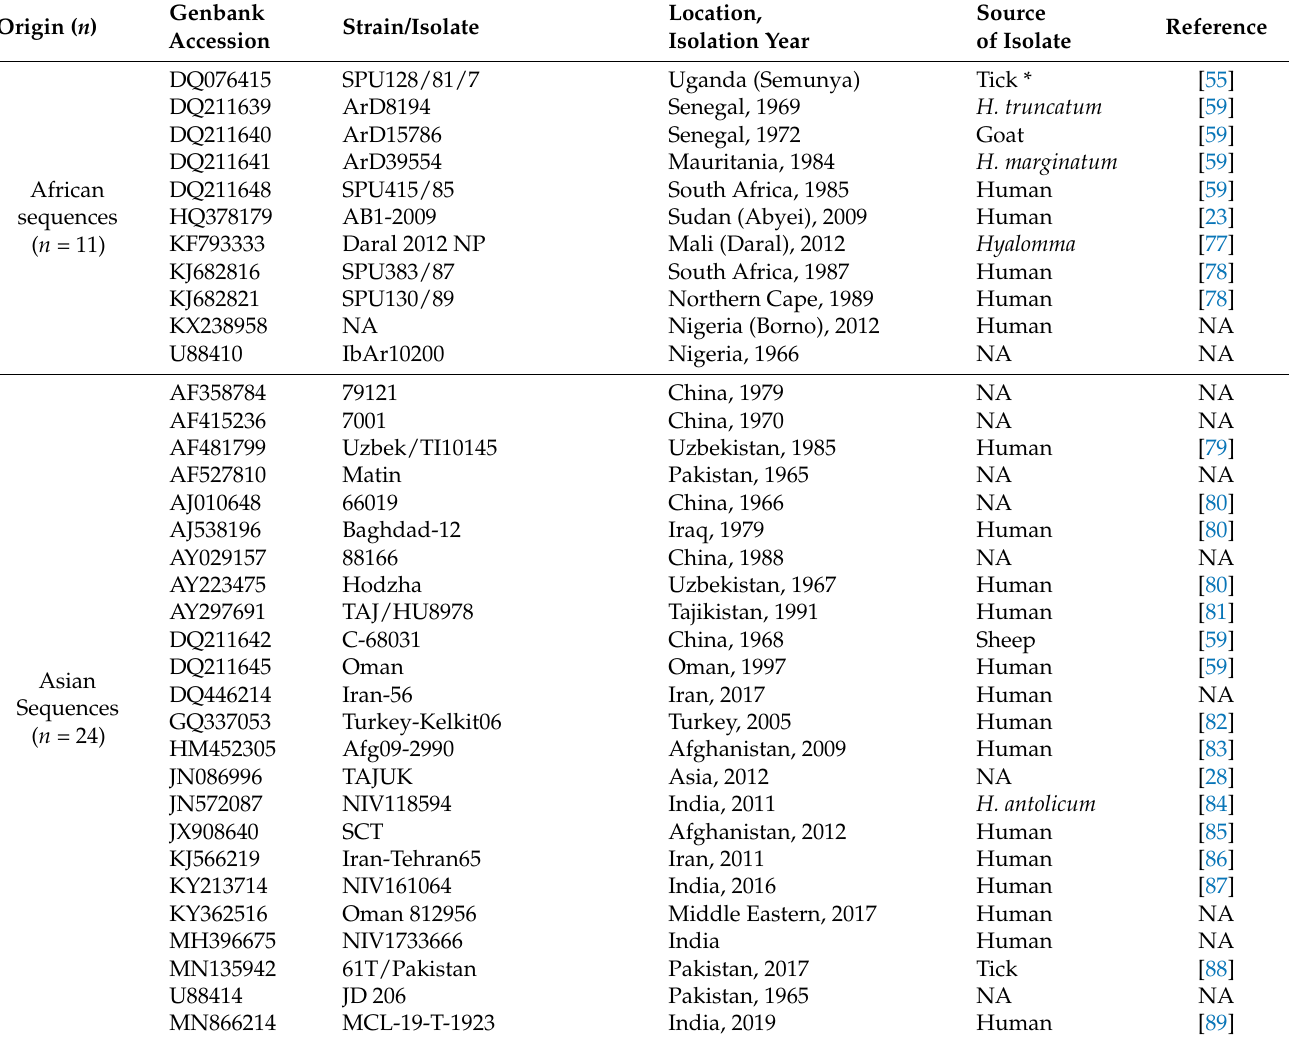
Table 2. Crimean–Congo haemorrhagic fever virus S-segment sequences retrieved from GenBank used in this study grouped by geographical origin of the strains/isolates to obtain a global con- sensus sequence for designing a set of primers for reverse-transcription loop-mediated isothermal assay for the detection of Crimean–Congo haemorrhagic virus RNA. NA, not available. “*” means: Not